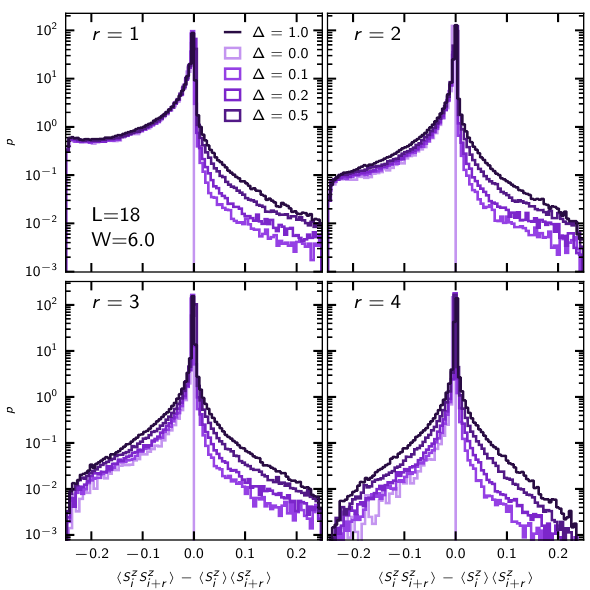
〉 S z for the disordered field c i i + r